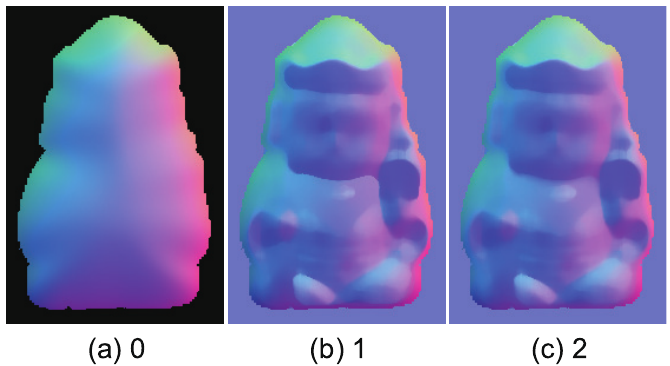
Figure 33. Intermediate state of surface normal through the proposed method: ( a ) Initial value of the surface normal, ( b ) the surface normal after 1 iteration, and ( c ) surface normal after 2 iterations. The proposed method is stable and coverges